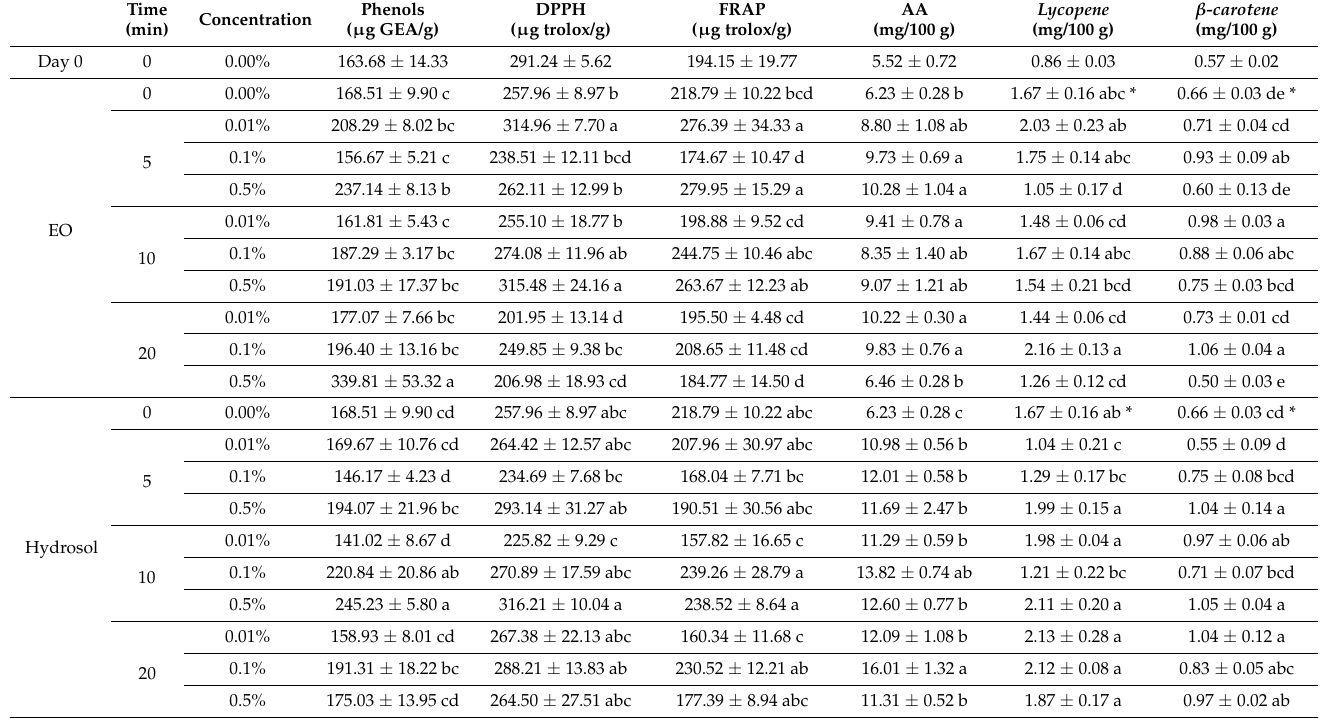
Table 5. Screening of O. dubium EO and hydrosol application effects on fresh tomato phenols, antioxidants (DPPH, FRAP), ascorbic acid (AA) and carotenoid ( Lycopene , β -carotene ) content when stored at 11 ◦ C for 12 days. Values presented as mean ± standard error of four biological replicates per treatment. Measurements for day 0 refer to the control. In each column and for each treatment (EO and hydrosol), significant differences ( p < 0.05) are indicated with different Latin letters. For control (0.00%), the asterisk (*) indicates the difference ( p < 0.05) on the initial and final days (day 0 and day 12,